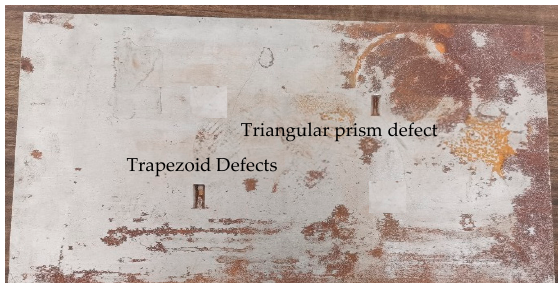
Figure 16. Schematic diagram of metal surface holding defects.